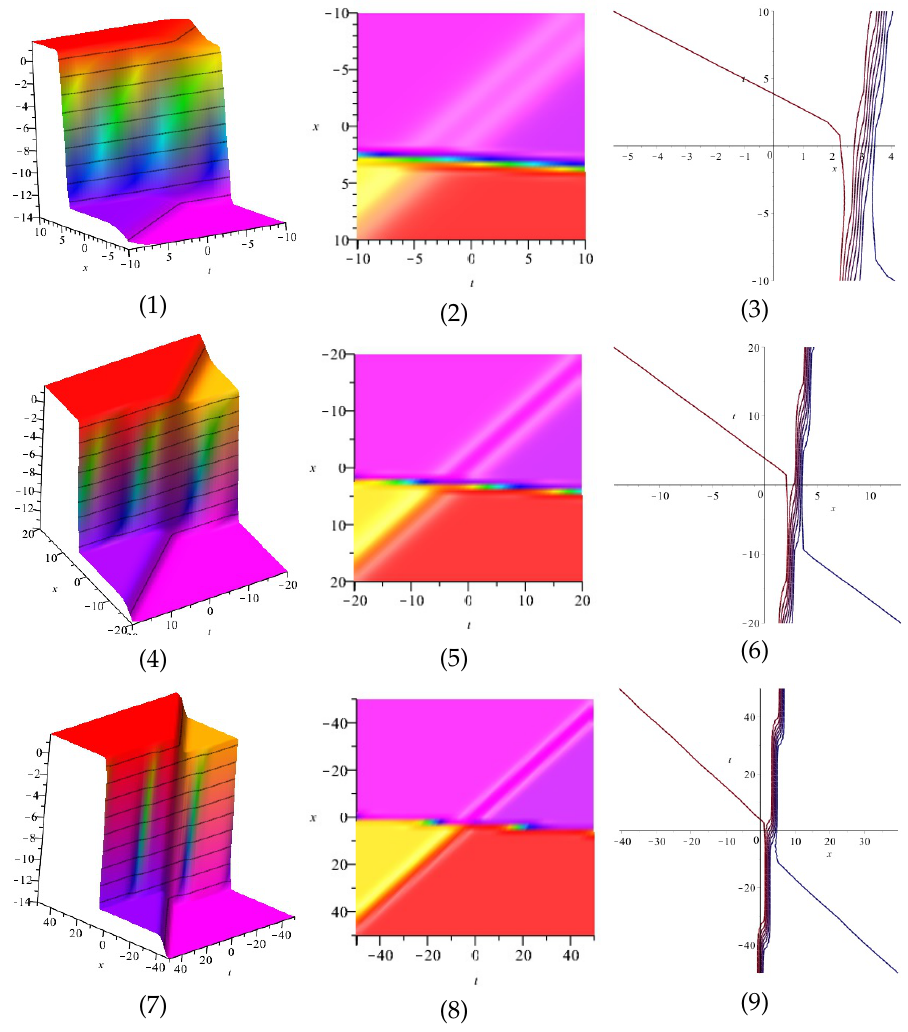
Figure 3. The 3D and 2D with the diagram of u 2,1 , in three different